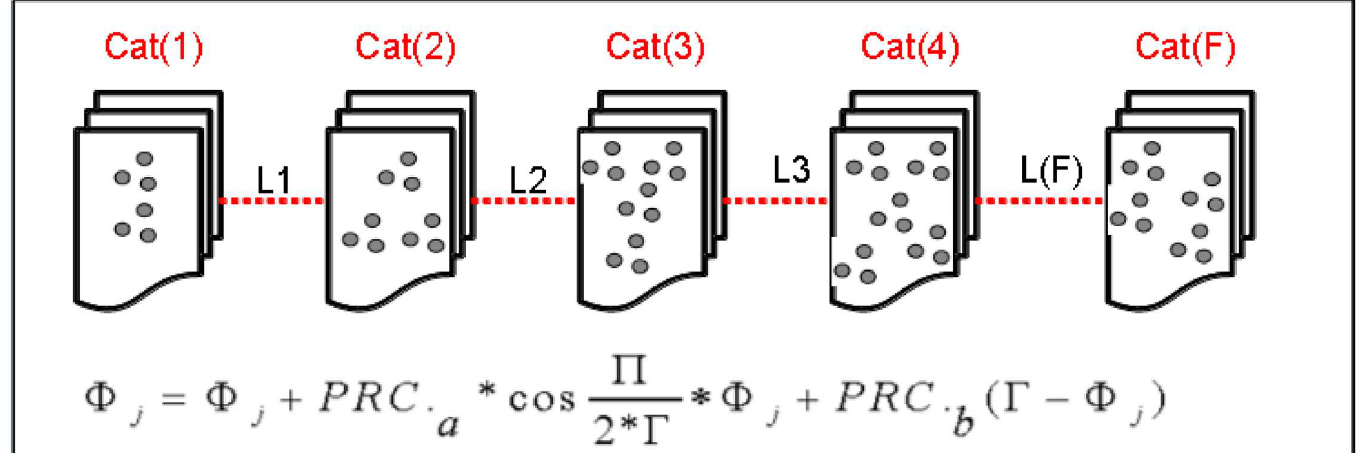
Fig 6. Framework of the TWPCO